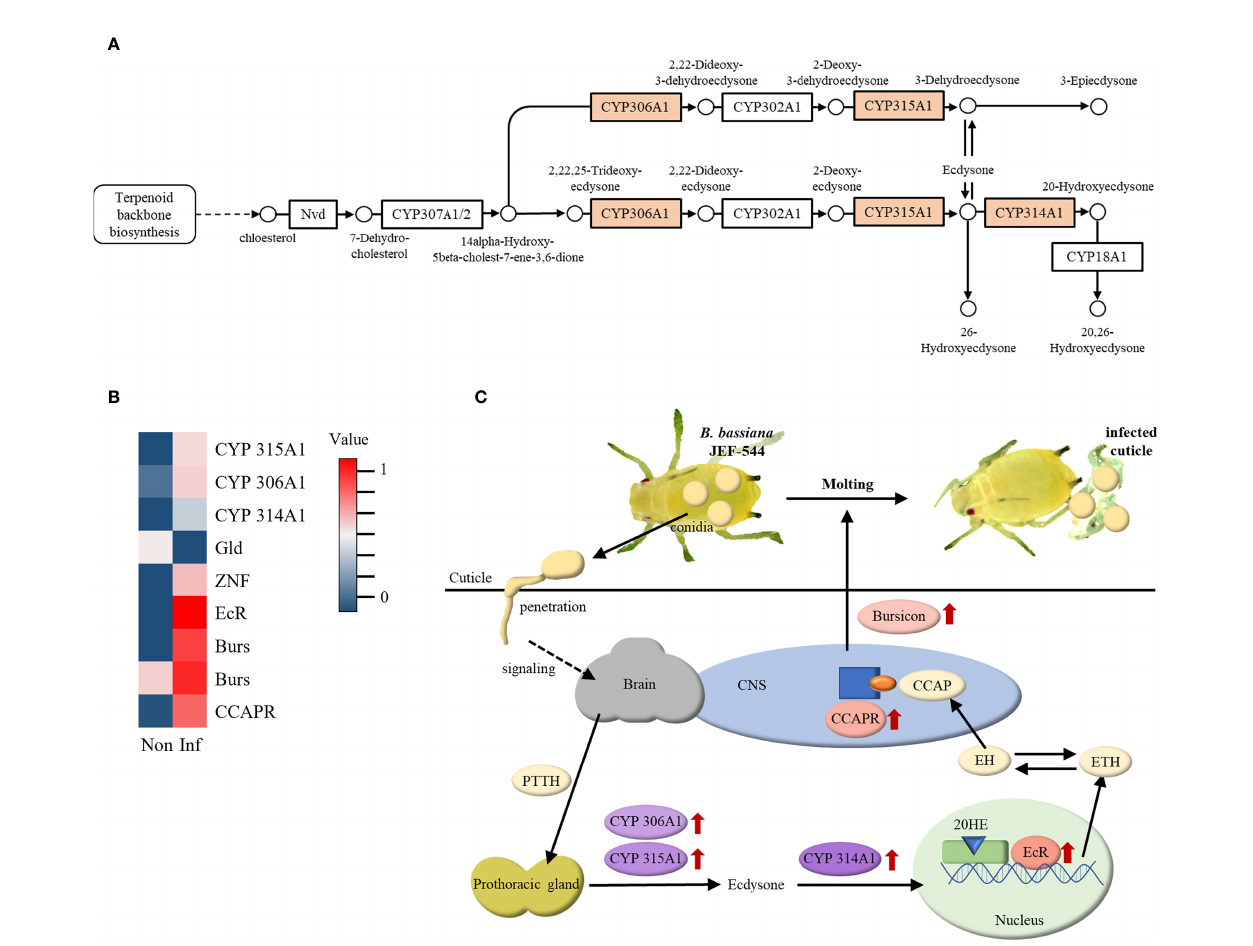
FIGURE 5 | Expression of insect hormone-related genes. (A) Enriched insect hormone biosynthesis pathway (analyzed by g:Pro fi ler), (B) Heatmap of insect hormone- related genes with expression level, and (C) Molting response in JEF-544-infected aphid as a defense